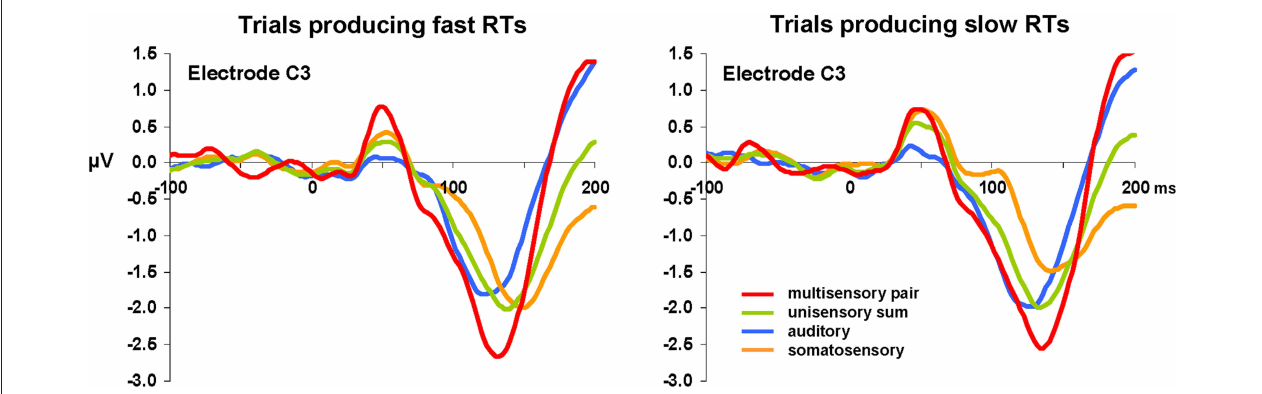
FIGURE 2 | Group-averaged voltage waveforms. Data are displayed at an exemplar left-lateralized central electrode site (C3) from each condition. Separate graphs depict ERPs from trials producing fast and slow RTs. Non-linear neural response interactions appear to start over the ∼ 40–80 ms post-stimulus onset for trials leading to fast but not to slow